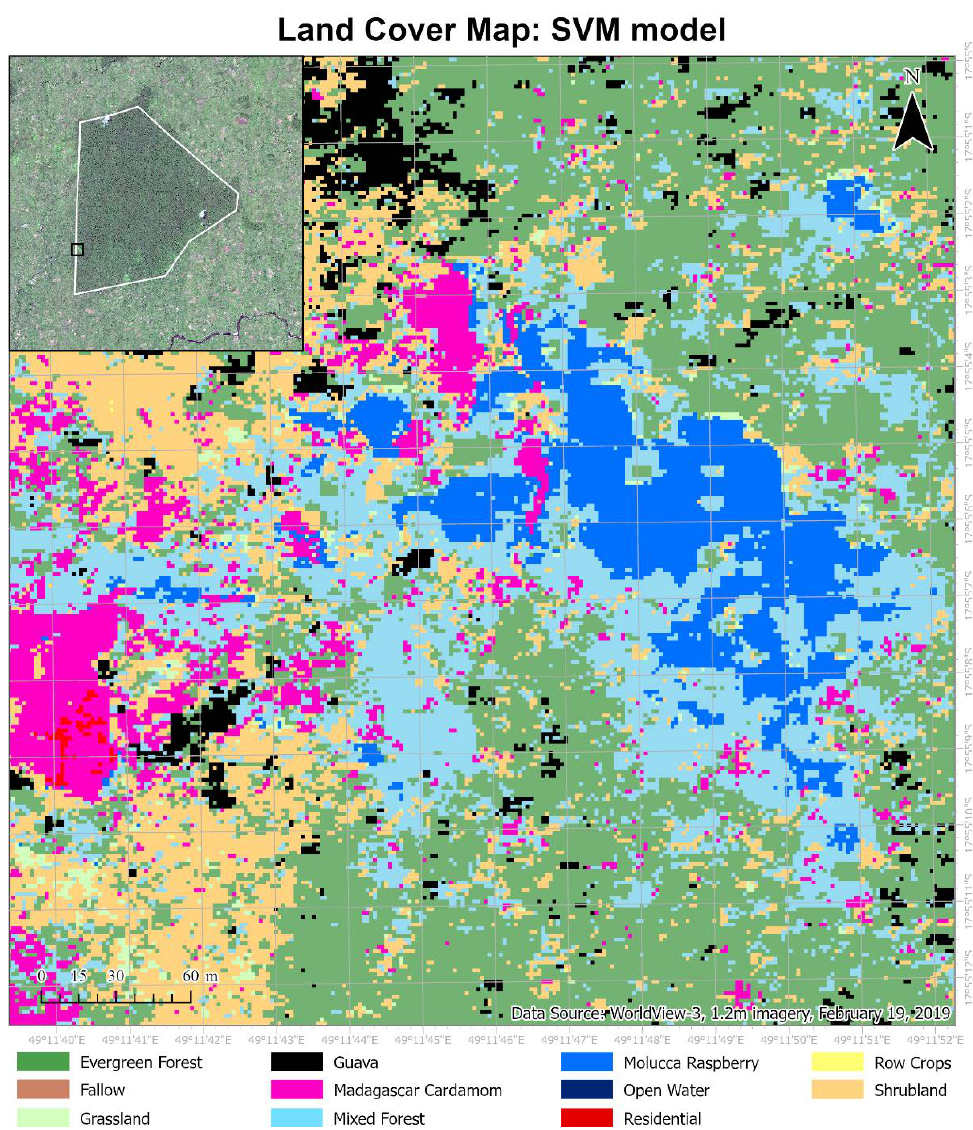
Figure 16. Classification map created using the SVM model, with an 88.6% overall accuracy, zoomed into a location on the western section of the BNR that shows the salt-and-pepper effect.